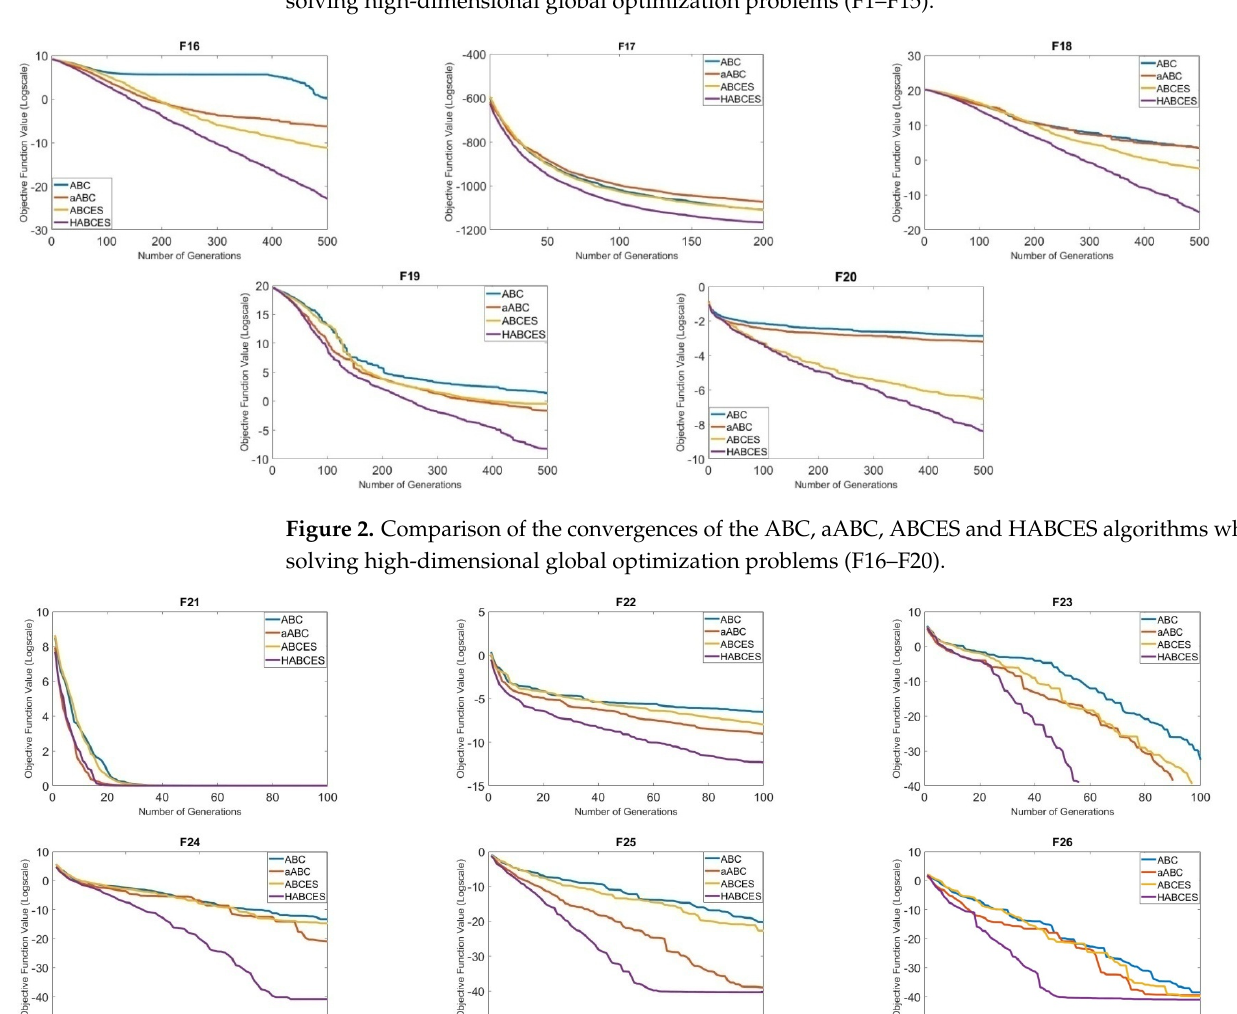
Figure 1. Comparison of the convergences of the ABC, aABC, ABCES and HABCES algorithms when solving high-dimensional global optimization problems (F1–F15).